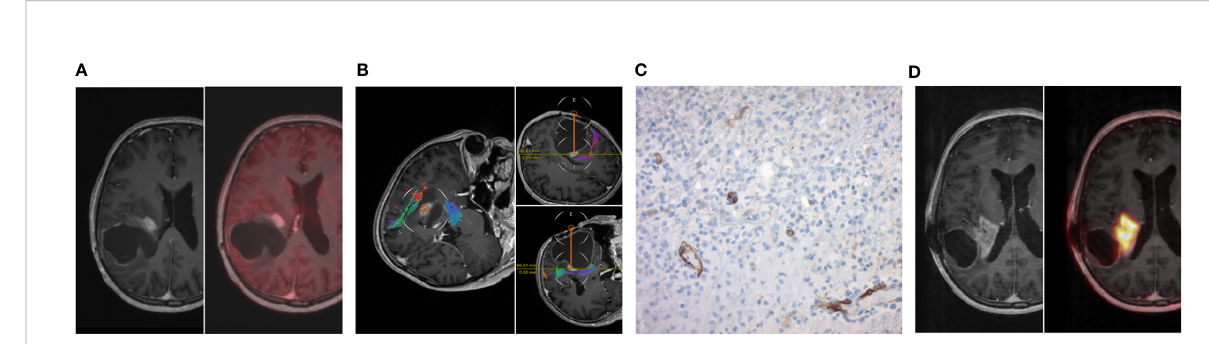
FIGURE 4 Illustrative case. (A) Preoperative MRI post contrast enhancement with standard [ 18 F]Fluoro-ethyl-tyrosine (FET) PET/MRI right before open biopsy. (B) In-line view of the open biopsy trajectory. (C) Corresponding PSMA staining of the open biopsy with predominant endothelial PSMA expression. (D) MRI post contrast enhancement with [Ga 68 ]Ga-PSMA PET/MRI only two months after the biopsy with maximum tumor-to-liver ratio of